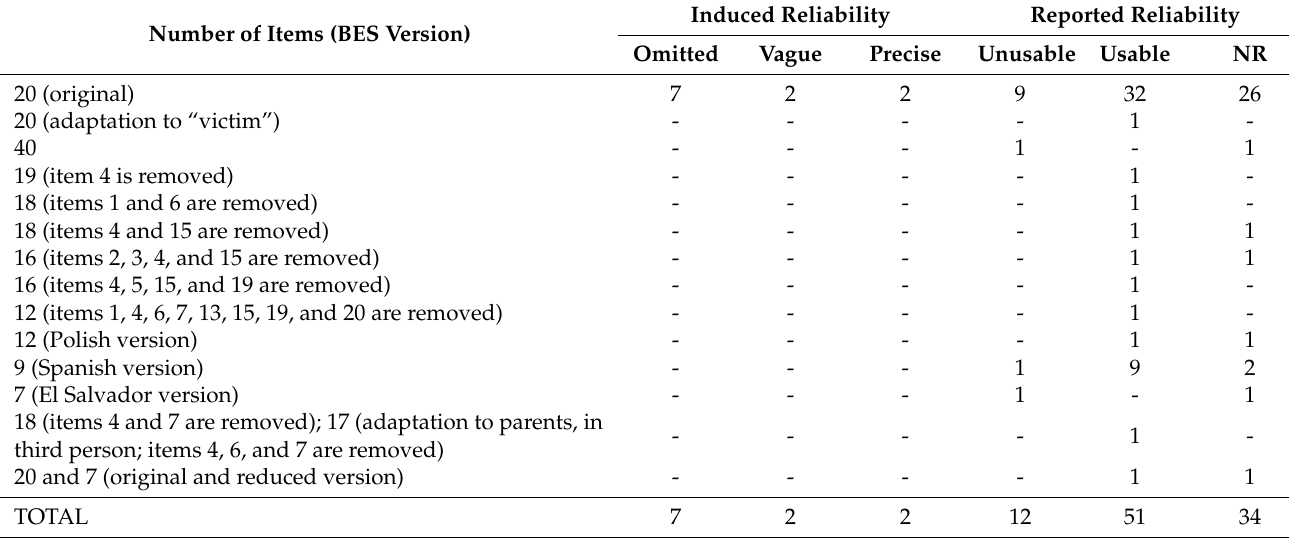
Table 2. Reliability